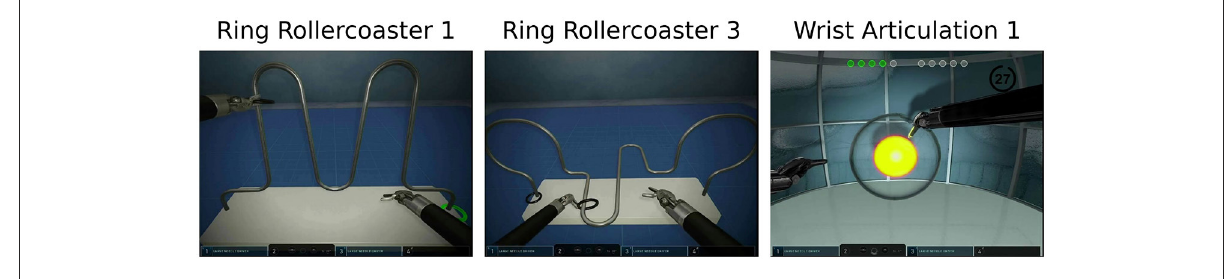
FIGURE1 Surgical simulation tasks.